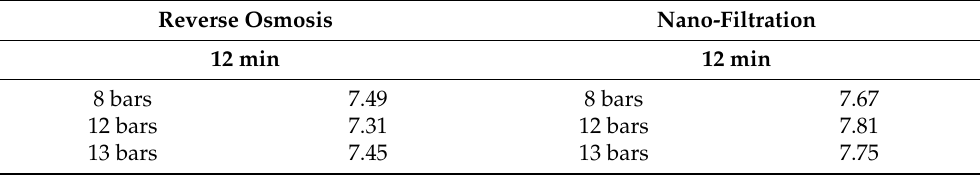
Table 4. pH Values for 12 min.